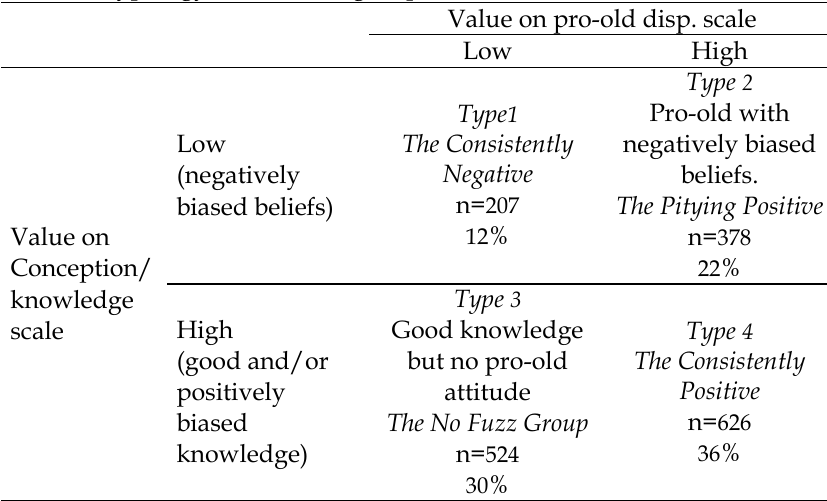
Table 3 . Typology of ”knowledge”/pro-old attitude Value on pro-old disp.